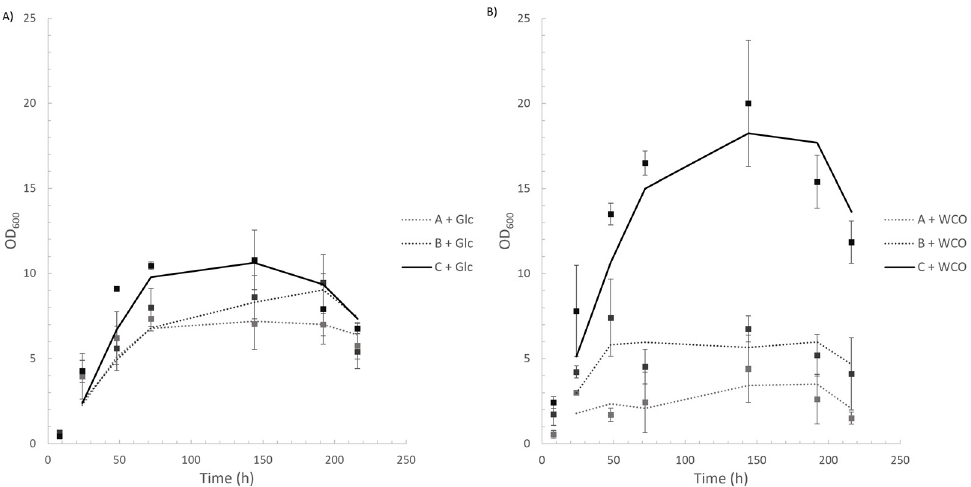
Figure 1. Small-scale batch cultures: optical density (OD 600 ) measurements. Conditions A, B, and C were tested in the presence of 3% w v − 1 glucose (Panel ( A )) or 10% v v − 1 WCO (Panel ( B )) for 216 h. Data are mean values of three different measurements, and bars represent standard deviations.